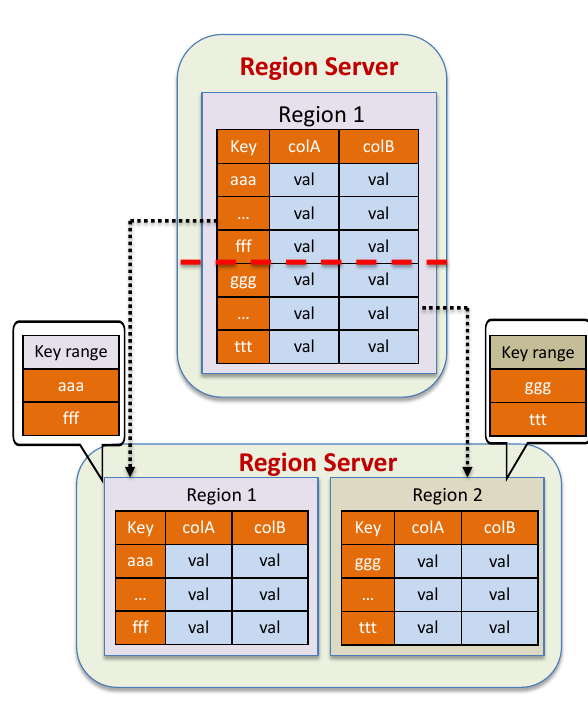
Figure 8. HBase table